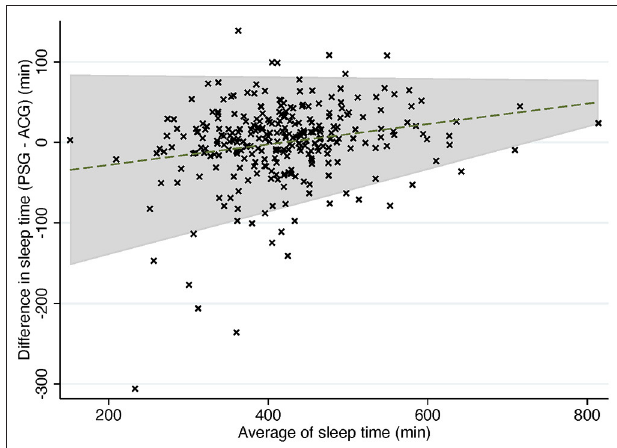
FIGURE 3 | Trend Bland-Altman plot: difference in sleep time compared to average of sleep time in PSG and ACG. Dashed line, mean difference. Gray area, 95% confidence interval for regression line. PSG, polysomnography; ACG,